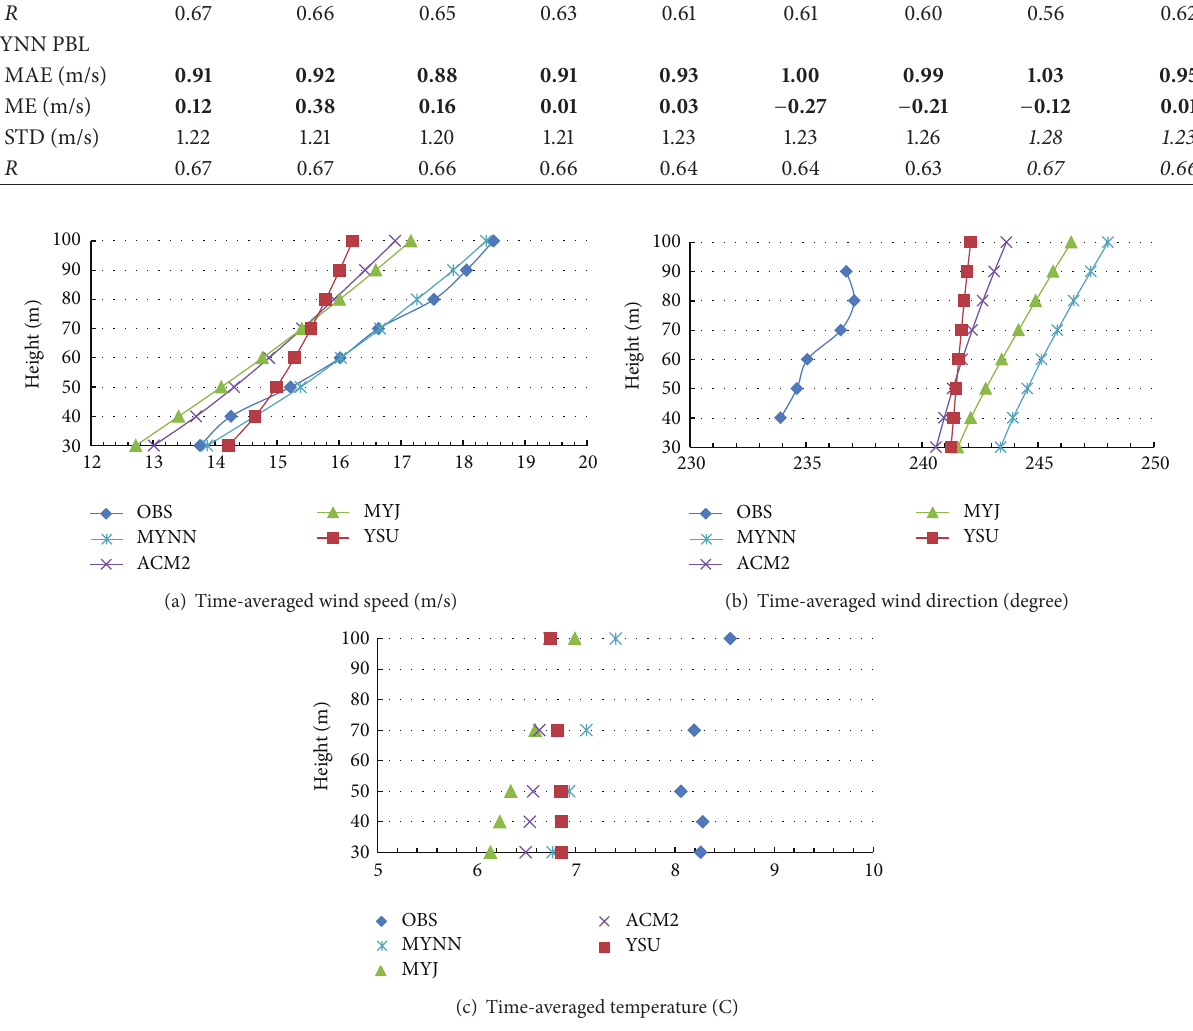
Figure 4: Time-averaged (16–18 March 2005) vertical profiles upto 100m ASL for (a) wind speed (m/s), (b) wind direction (degree), and (c) temperature ( ∘ C). The model results of different PBL schemes are compared with the FINO1